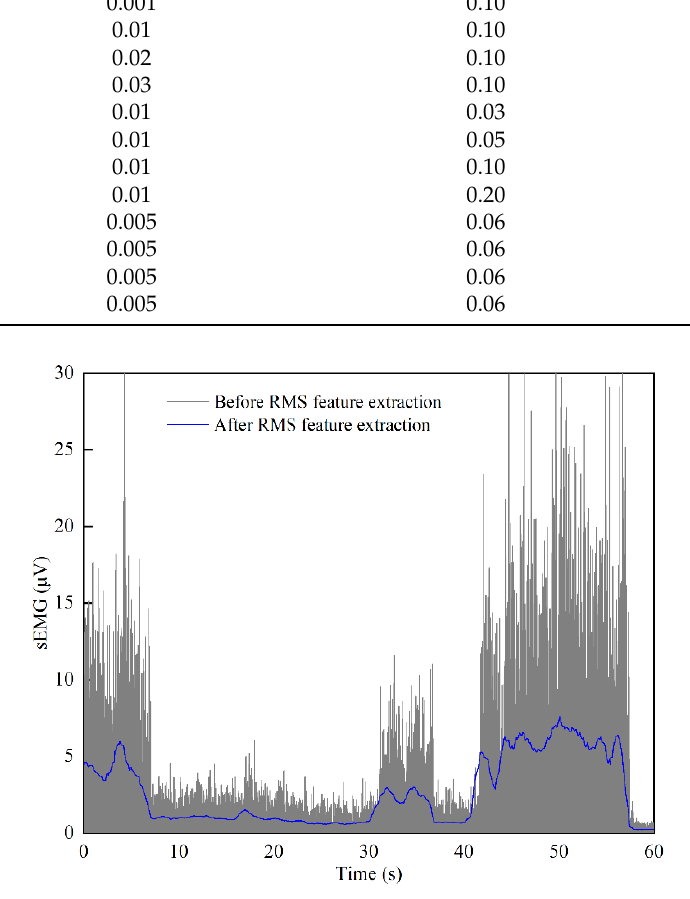
Figure 13. sEMG signals before and after RMS feature extraction.